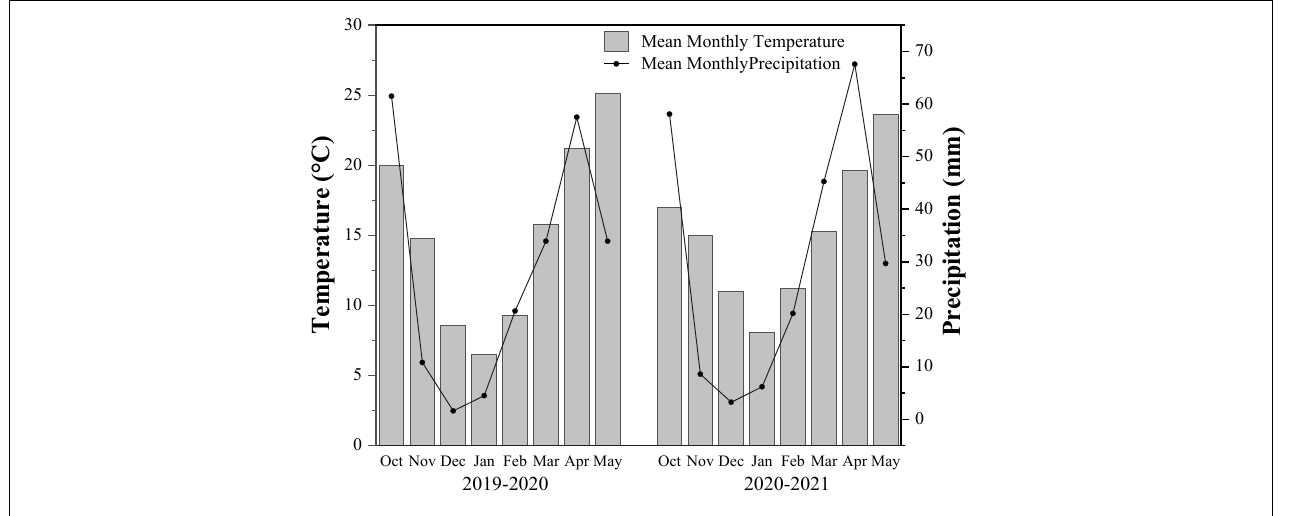
FIGURE 1 | Monthly average temperature and precipitation data for the two-growing season